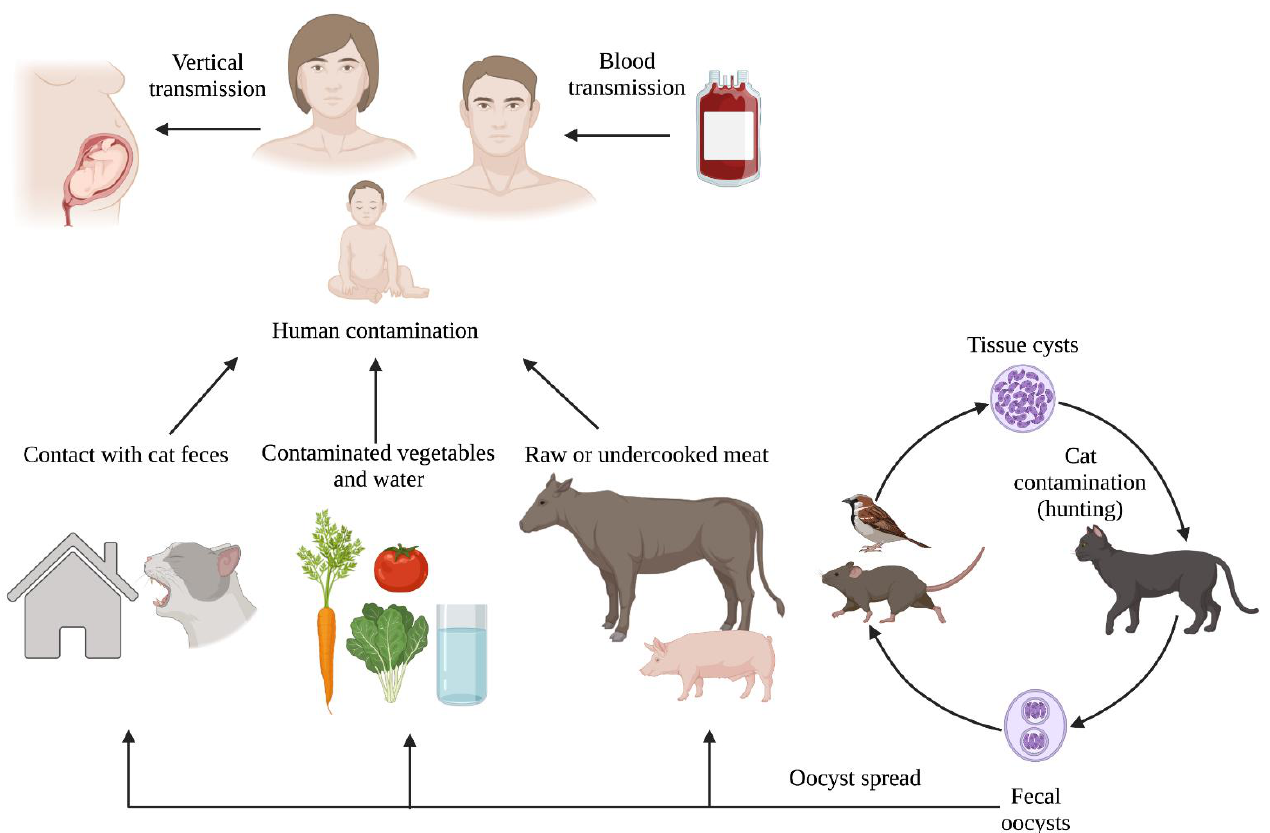
Figure 2. Major routes of transmission of T. gondii. Schematic based mainly on Esch and Petersen, 2013.